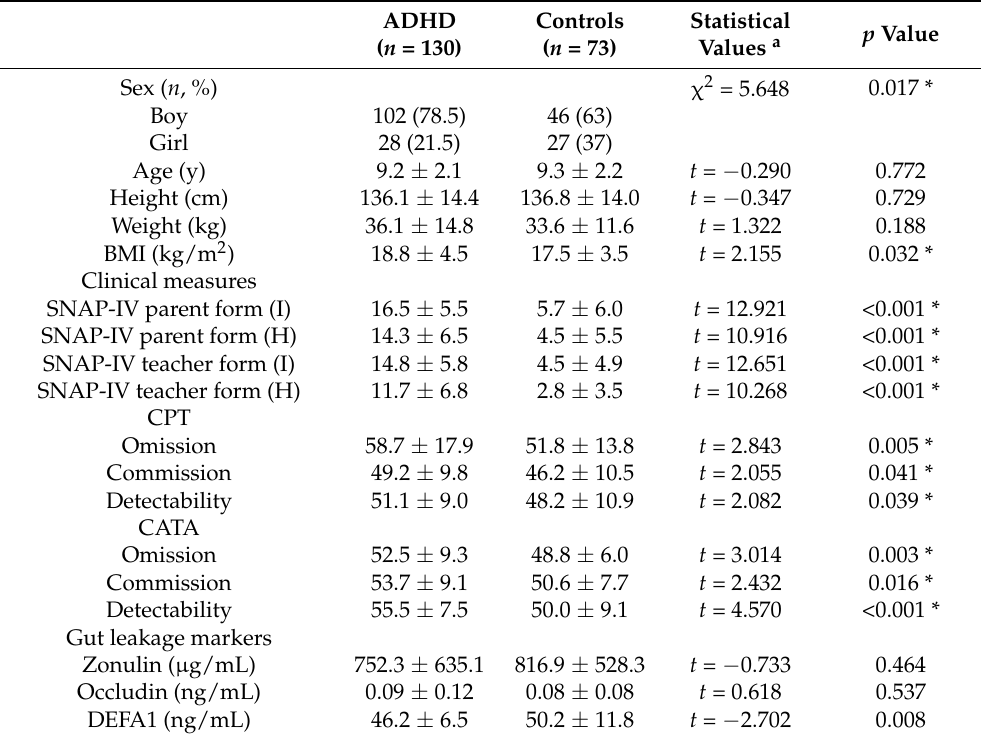
Table 1. Characteristics of patients with ADHD and healthy control